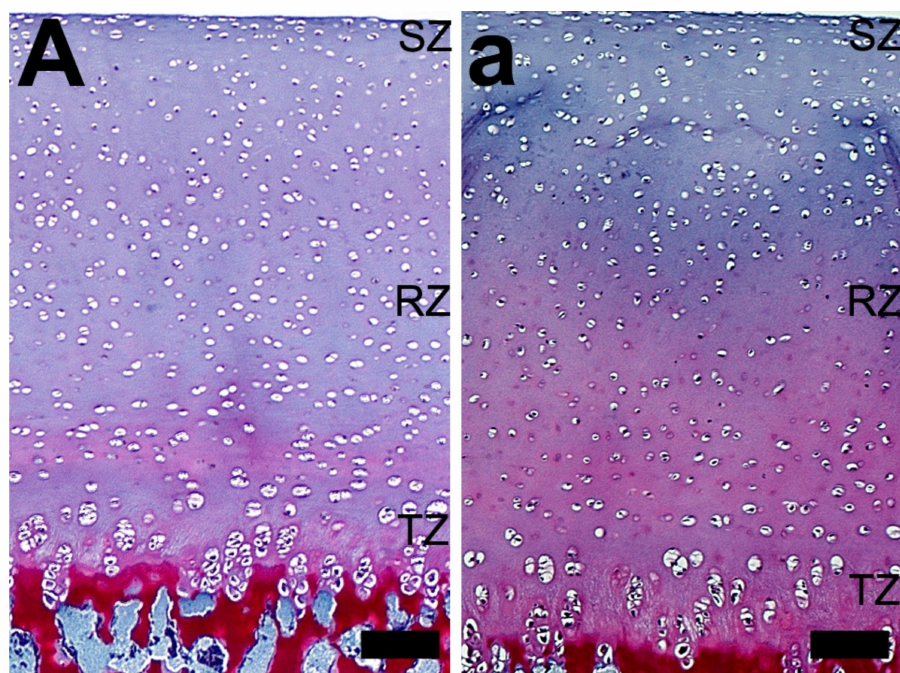
Figure 6. The e ff ect of dietary supplementation with 2-Ox on the femoral articular cartilage structure in glucocorticoid-induced, growth-retarded, mature gilts (Safranine O staining). ( A ) The articular cartilage of the control group (growth-retarded gilts not supplemented with 2-Ox). ( a ) The articular cartilage of the 2-Ox group (growth-retarded gilts supplemented with 2-Ox at a dose of 0.4 g / kg b.w. / day). Di ff erences were observed in the distribution and staining intensity of proteoglycans in the femoral articular cartilage (darker Safranine O staining is associated with a higher proteoglycan content). The zones of the articular cartilage: superficial zone (SZ), transitional zone (TZ), and radial zone (RZ). Each scale bar shows 50 µ